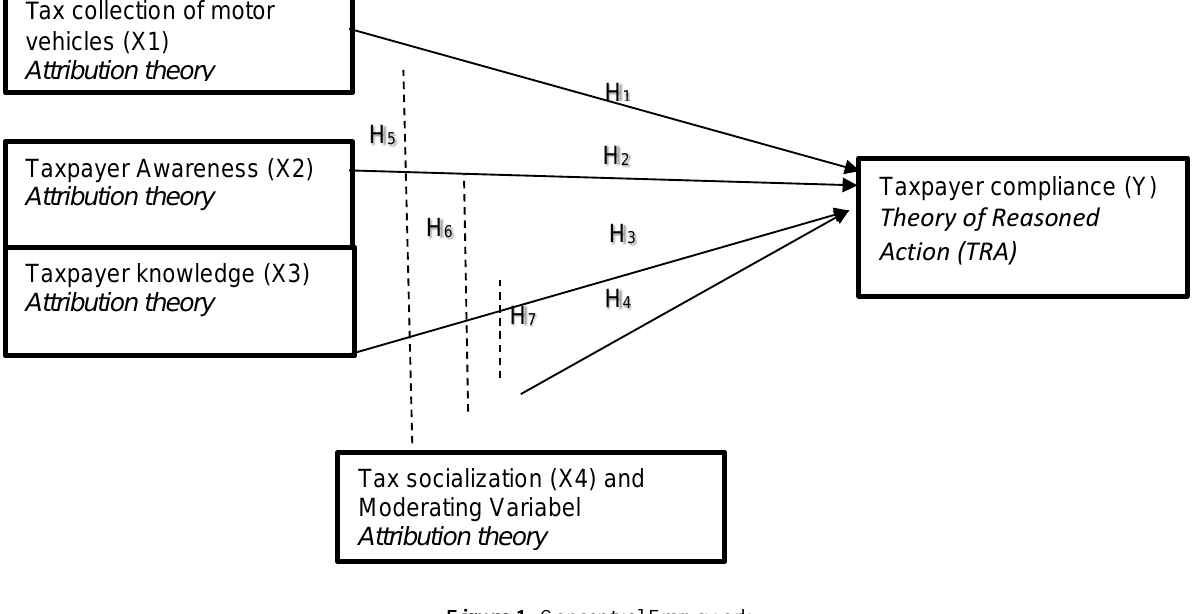
Figure 1: Conceptual